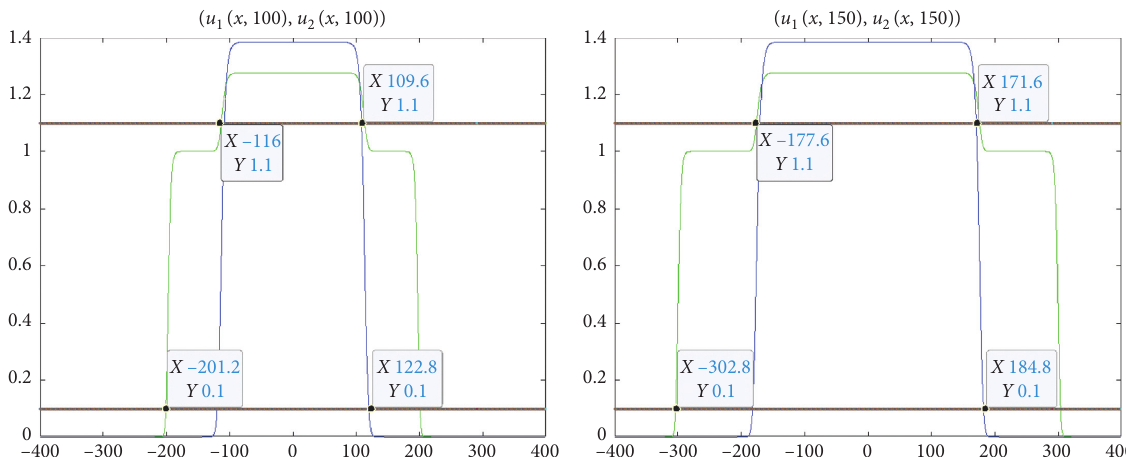
Figure 2: Spatial plots of u